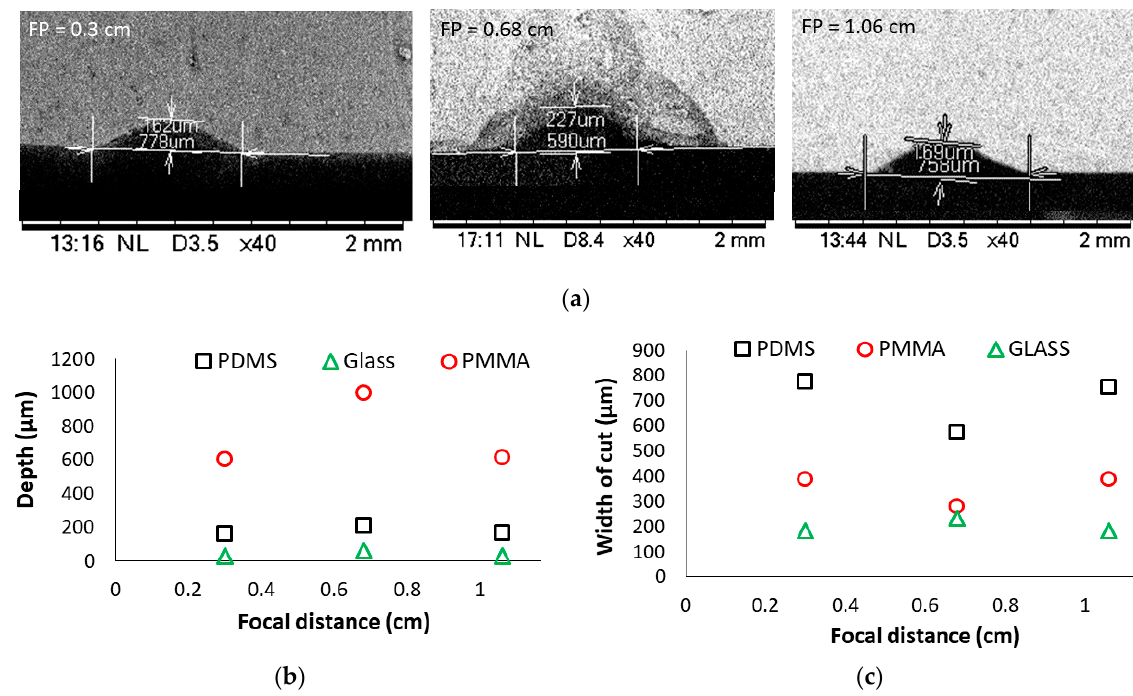
Figure 2. The effect of focal distance on the microchannel characteristics ( a ) SEM measurement of PDMS microchannel at three different focal distances, ( b ) depth of the channel, and ( c ) width of the channel.